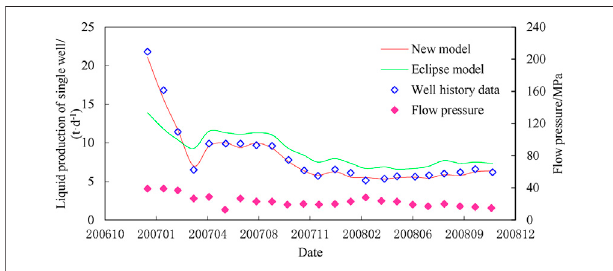
FIGURE 10 | The liquid production comparison results of the well W587-X3.